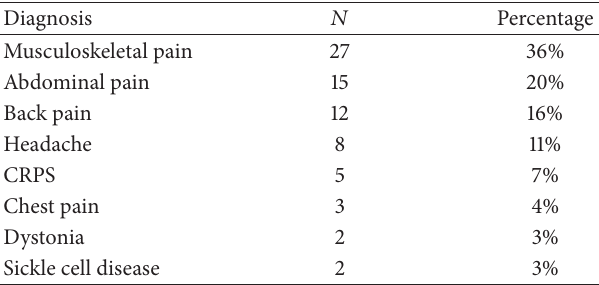
Table 2: List of referral diagnoses (CRPS: Chronic Regional Pain Syndrome).